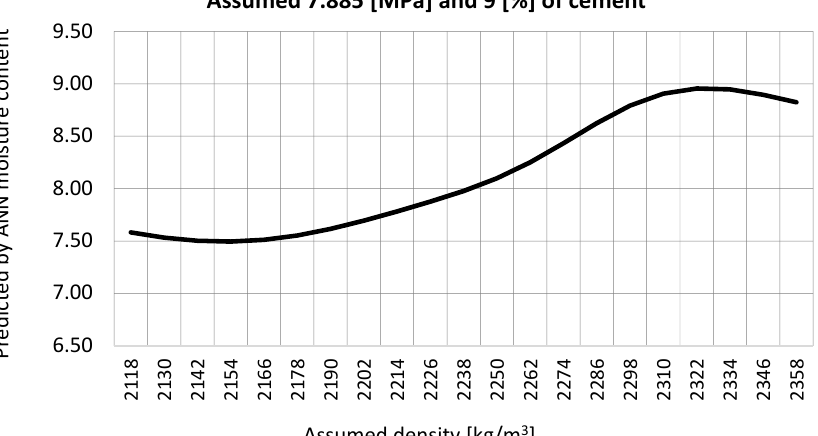
Figure 13. Predicted final moisture content for given density varied from 2118 to 2358 [kg / m 3 ] for required compressive strength 7.885 [MPa] and assumed 9 [%] addition of cement.